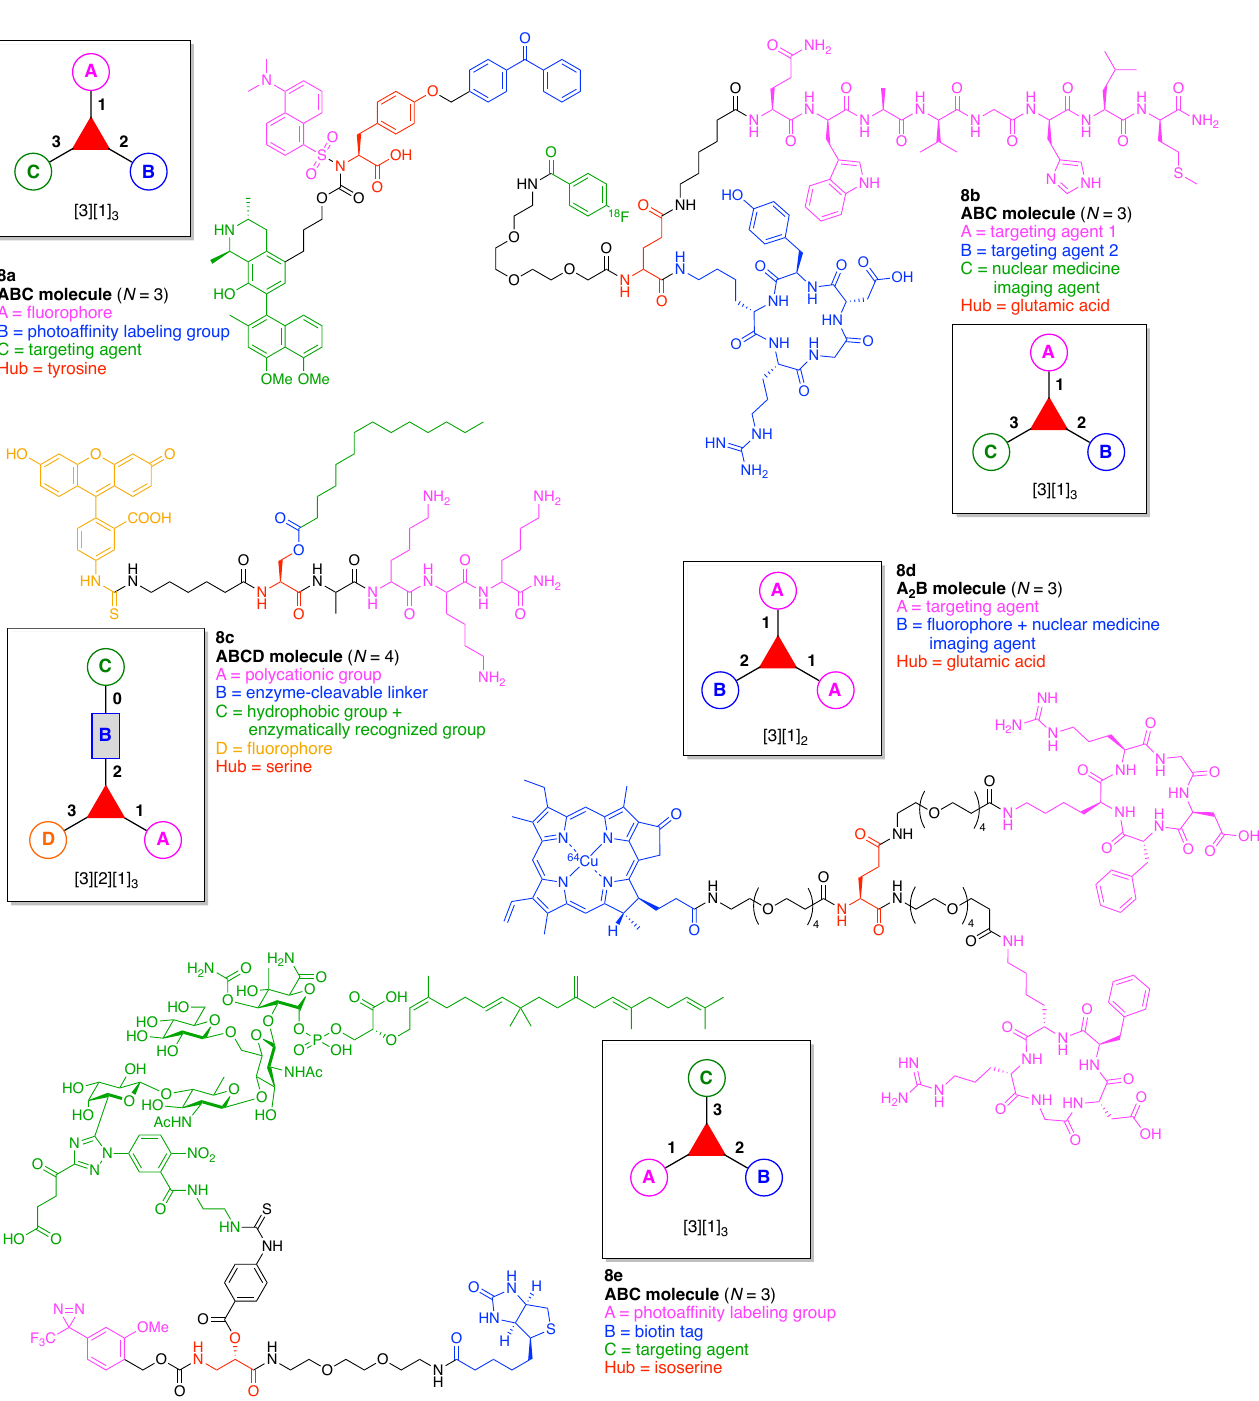
Figure 25. Five examples each with one (non-lysine) amino acid hub.